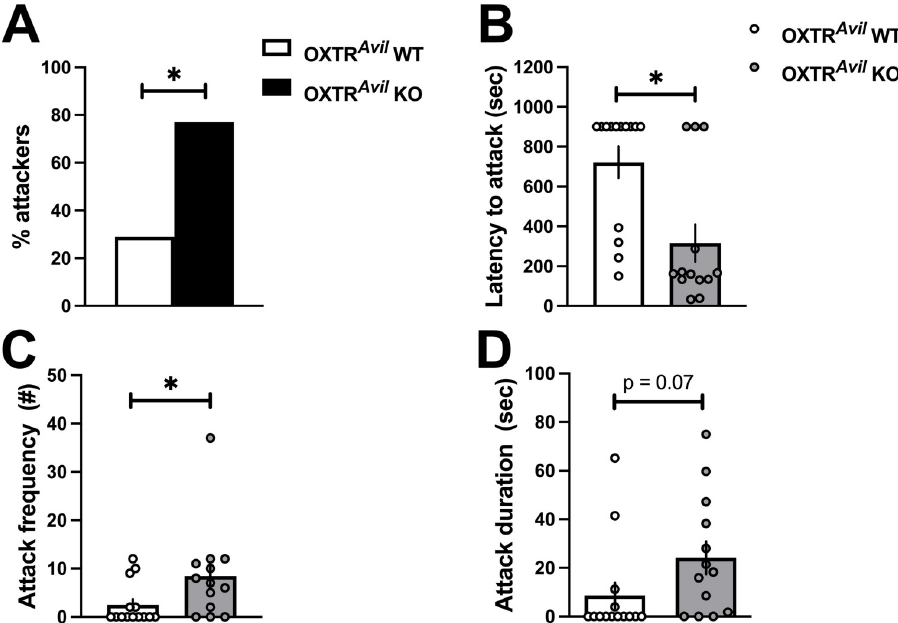
Fig 4. Increased aggression in OXTR Avil KO males compared to OXTR Avil WT males in the resident intruder test (RIT). A higher percentage of OXTR Avil KO males (black bar) displayed aggression in the RIT compared to OXTR Avil WT males (white bar, A). OXTR Avil KO males (gray markers) also had reduced latencies to fight (B; F 1, 27 = 11.862, p < .01; d = 1.27) and increased frequencies of attack (C; F 1, 27 = 4.719, p < .05; d = 0.83) compared to OXTR Avil WT males (white markers). Duration of fighting was not significantly different between OXTR Avil WT and KO males (D). Frequency and duration are graphed as individual data points and group averages ± standard error of the mean. A latency of 900 seconds was assigned to subjects that did not attack during the 15-minute-long test. See also S4 Fig in S1 File, S1 Table in S1